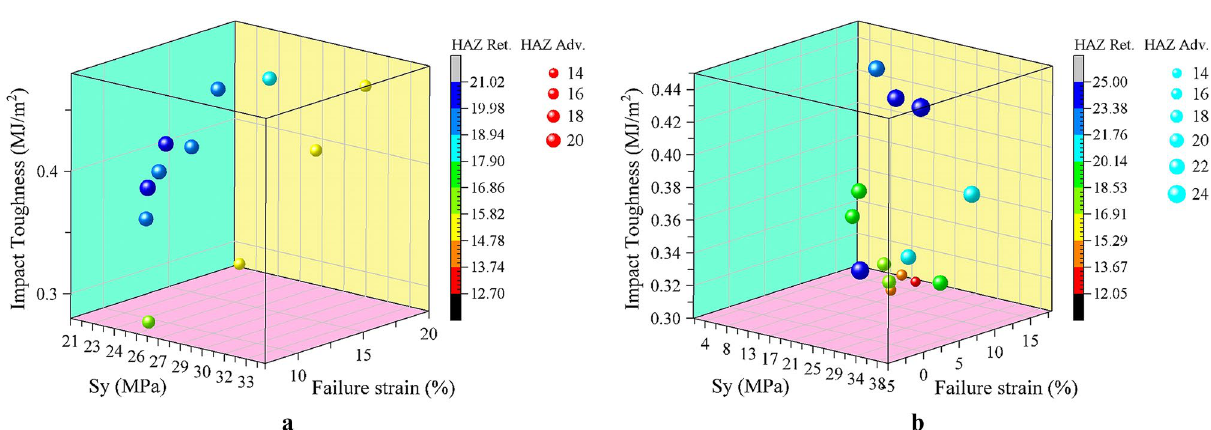
Figure 12. Multi-objective optimization Pareto front: ( a ) conical pin, ( b ) threaded cylindrical pin.